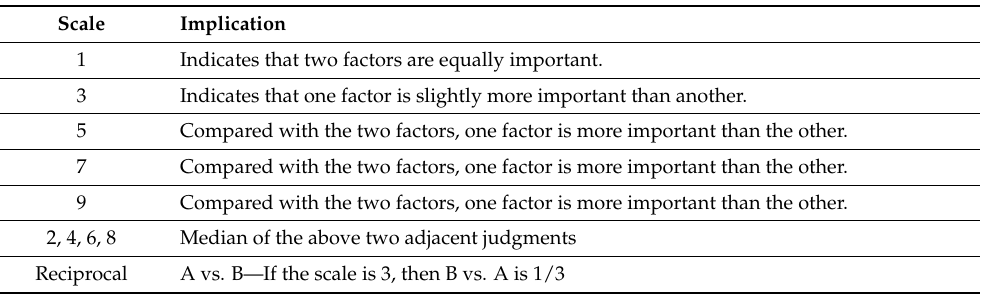
Table 1. Scaling of the judgment